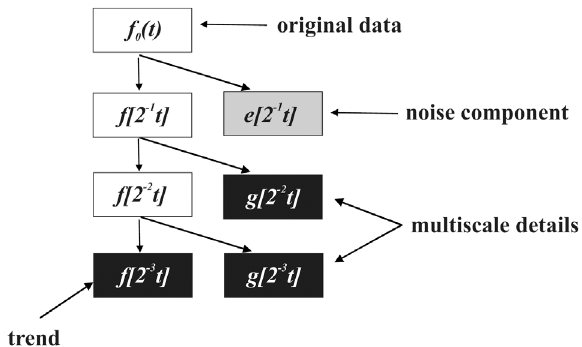
Figure 1. Approximated components in the wavelet domain (high- lighted in black).